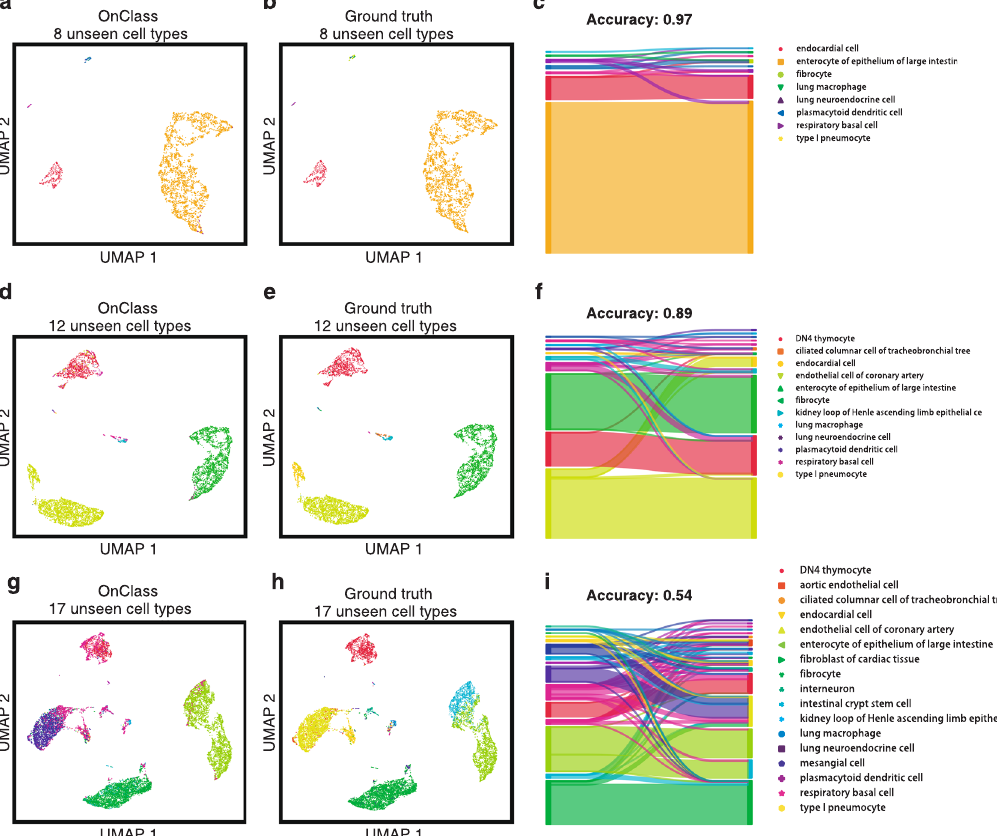
Fig. 3 OnClass can accurately assign cell types that are not present in the training set. a , b , d , e , g , h 2-D UMAP plots showing the predicted Cell Ontology terms of OnClass ( a , d , g ) and ground truth labels ( b , e , h ) for 8 ( a , b ), 12 ( d , e ), and 17 ( g , h ) unseen Cell Ontology terms in Muris FACS. The presence of the same color between OnClass predicted labels and ground truth labels means correct annotation. c , f , i , Sankey diagrams of the resulting mapping between predicted labels (left) to ground truth labels (right) for 8 ( c ), 12 ( f ), and 17 ( i ) unseen Cell Ontology